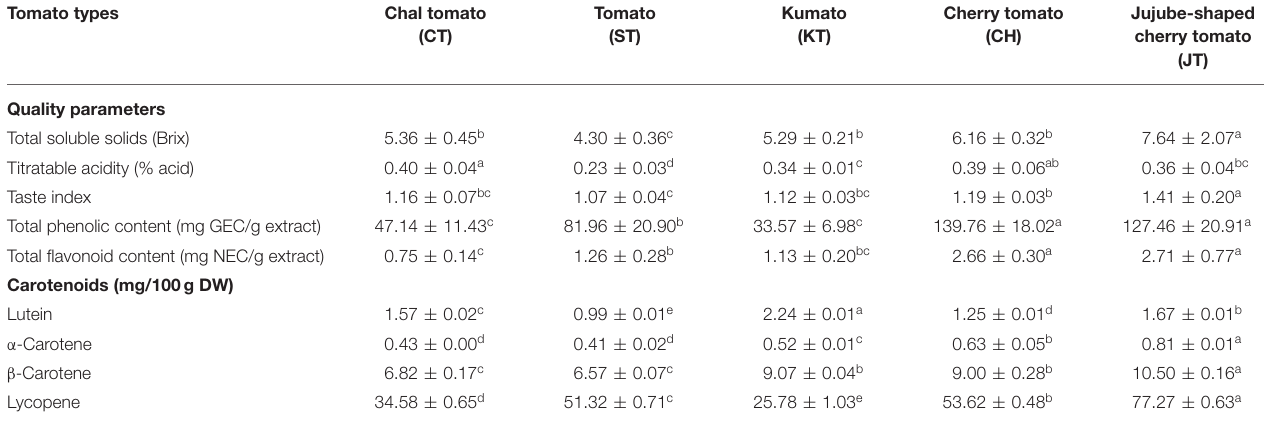
TABLE 2 | Physicochemical characters of five types of tomato